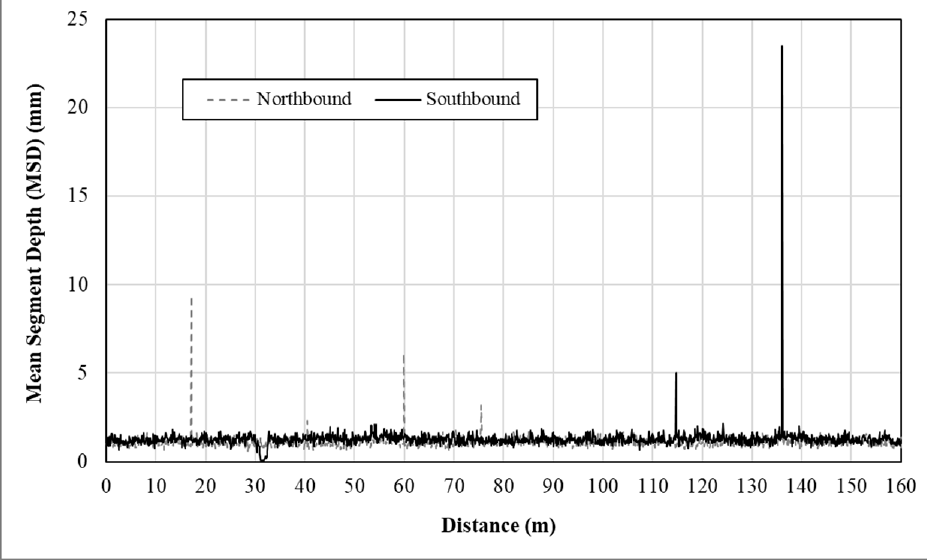
Figure 3. Graphical illustration of mean segment depth (MSD) measurements. As illustrated earlier, macrotexture is categorized as the texture with wavelengths ranging from 0.5 mm to 50 mm and peak to peak amplitudes ranging from 0.01 mm to 20 mm. To further examine the spikes retained in the texture data, the MSD measurements and surface conditions were assessed after 7 months of service at two HFST sites, including US-24b, and SR-23, as shown in Figure 4. At the HFST site on US-24b, the spikes represent mainly the delamination in the surface of HFST. At the HFST site on SR-23, the spikes are due mainly to the surface defects, such as wide cracks and localized pop-off due to severe deterioration or raveling of cracks. Presented in Table 4 are the summary statistics of the MSD measurements before and after removing the spikes in the measurements. Evidently, the spikes affect the standard deviation and coefficient of variation more significantly than the mean (i.e., MPD). As a general rule of thumb, therefore, spikes greater than 20 mm, i.e., the maximum amplitude of macrotexture defined by PIARC, are removed from the MSD